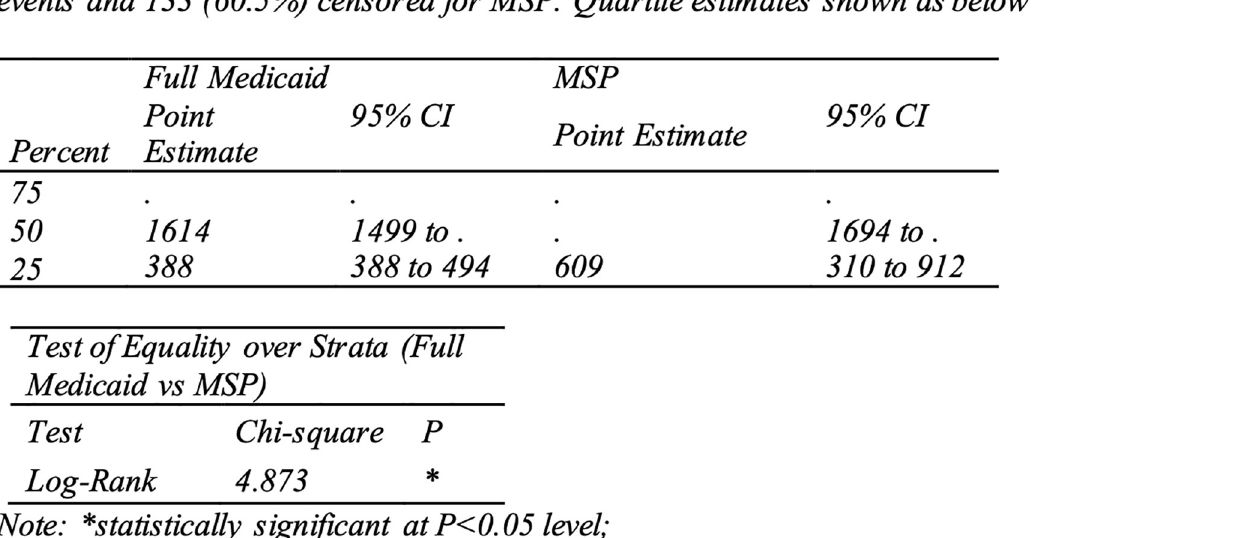
Fig 2. Kaplan Meier curve for the fraction of patients without a 180-day gap between two prescriptions fills since initiation—stratified by full Medicaid and MSP beneficiaries.